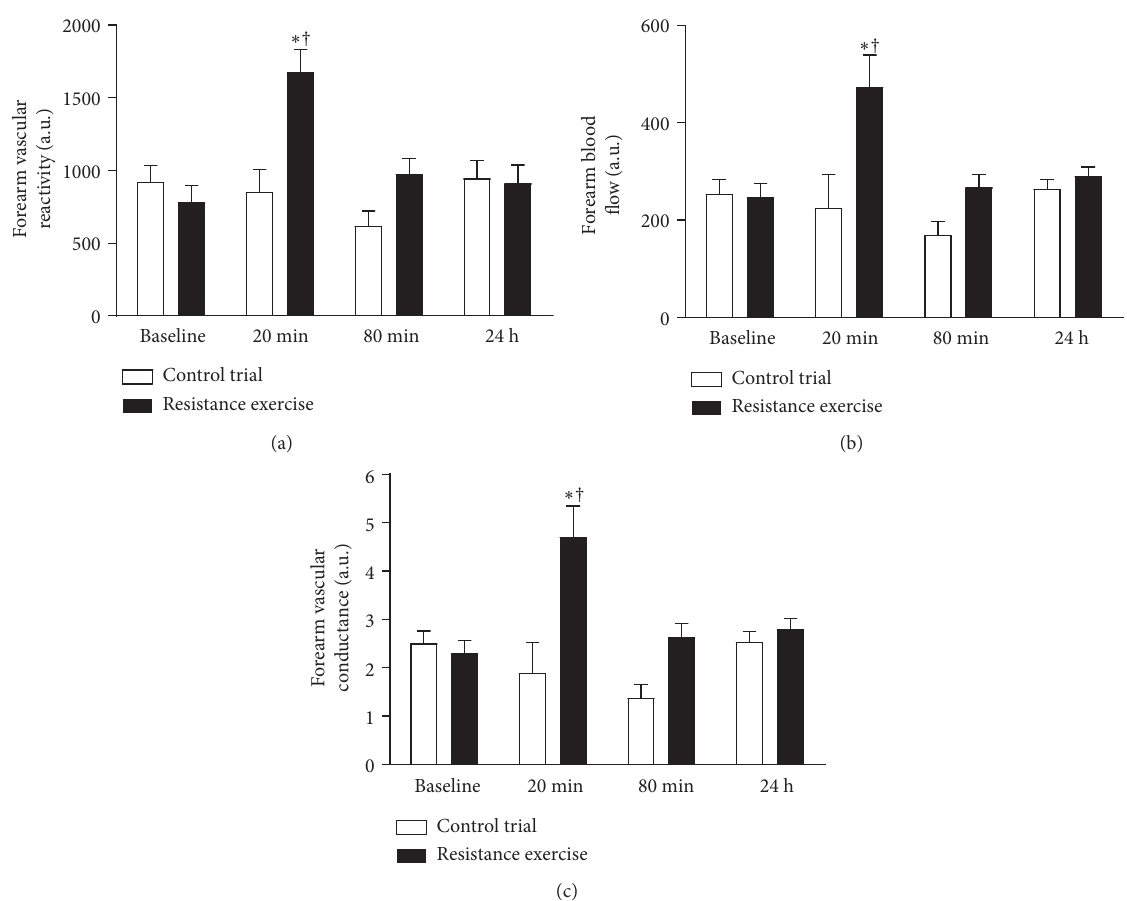
Figure 3: Forearm vascular reactivity (a), forearm blood flow (b), forearm vascular conductance (c) assessed by venous occlusion plethysmography before and after RE and CTR trial. ∗ p < 0 . 05 versus baseline; † p < 0 . 05 versus same moment of CTR trial.